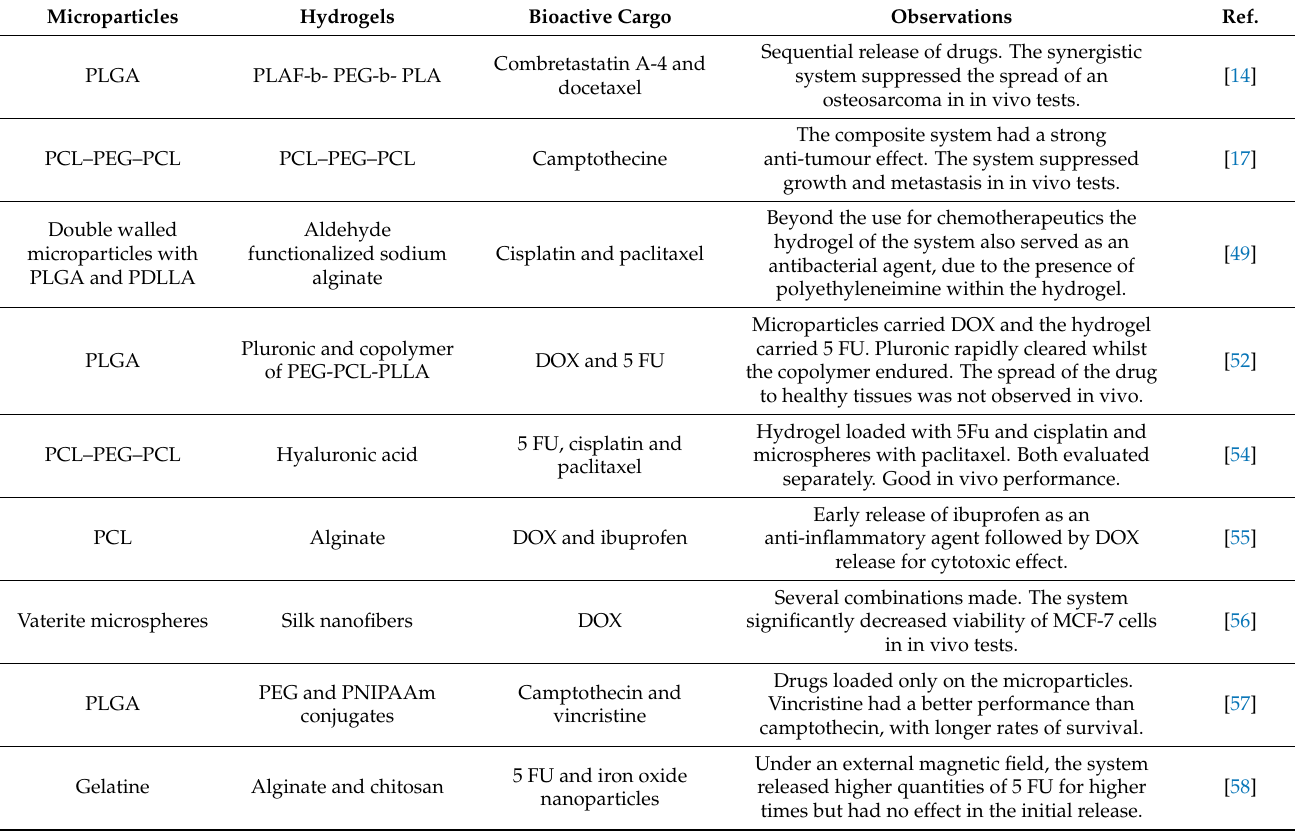
Table 1. Microparticles in hydrogel system used for cancer